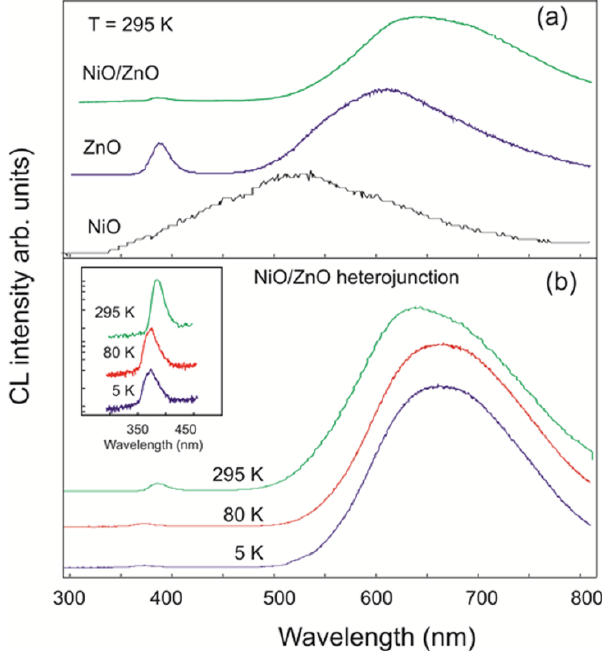
Figure 3. ( a ) Normalized CL spectra at room temperature for NiO, ZnO and composite nanostructures; ( b ) Normalized CL spectra for NiO/ZnO heterostructures shown at three different temperatures. Inset shows the effect of temperature on near band gap